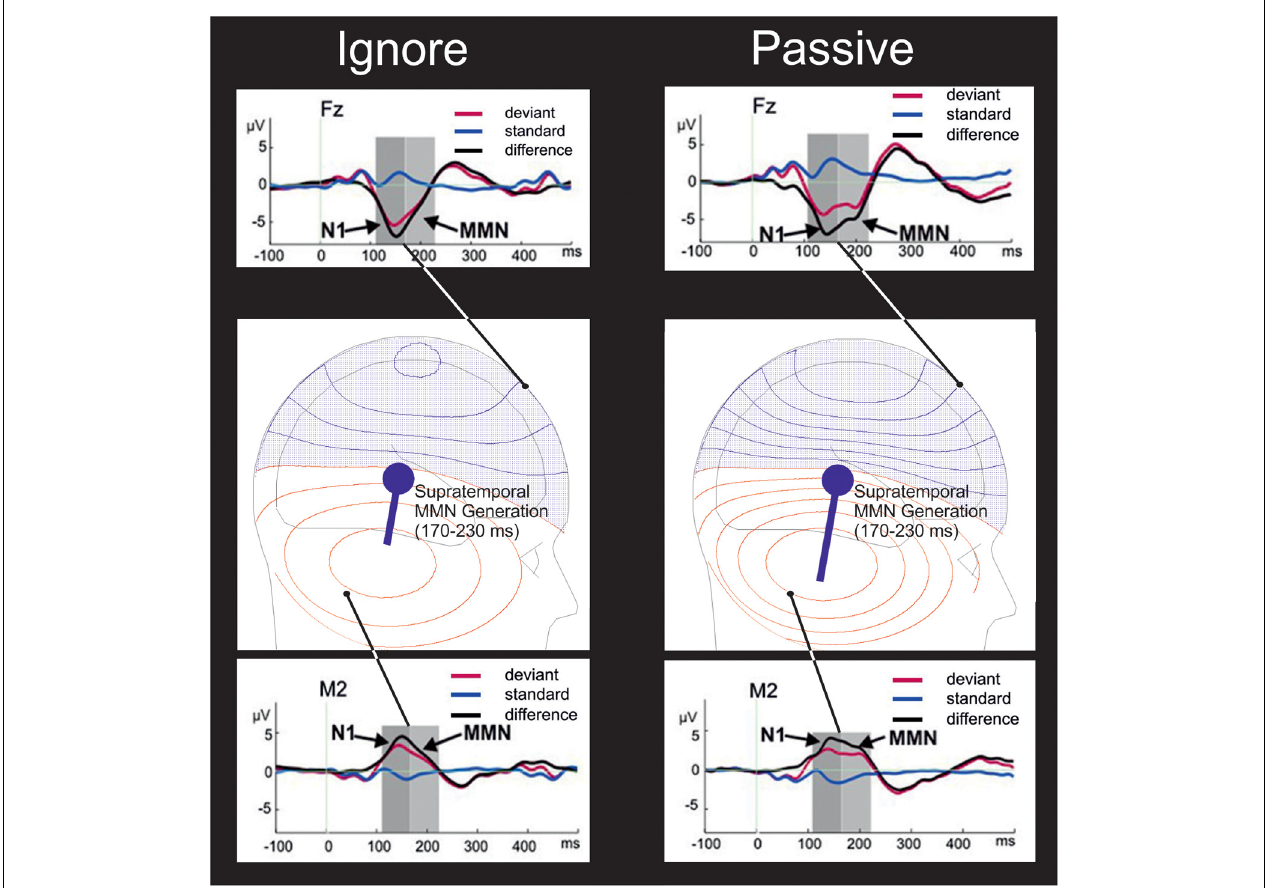
FIGURE 1 | Theoretical schematic of the influence of attention on supratemporal MMN generation. In the “ignore” condition (left panels) , participants performed a visual task in which attention is drawn away from the to-be-ignored auditory stimulation by a primary visual task of detecting a scene in a silent movie. In the “passive” task (right panels) participants watched that movie whilst just ignoring the sound. As illustrated in the middle row of panels, attention to the sounds in the passive task is assumed to increase supratemporal MMN generation by a population of tens of thousands of similarly oriented axons/dendrites of neuronal elements firing simultaneously within each hemisphere in response to auditory deviance, the cumulative action of which can be approximated by a dipolar source of a primary current (denoted by a blue circle) in each hemisphere giving rise to volume currents passing through the brain, liquor, skull, and scalp to Electroencephalogram (EEG) electrodes. The moment of that dipole – represented by the length of a straight line vector originating from the dipolar source location tangentially oriented to the skull – is reduced by the engagement of visual attention during the “ignore” task, attenuating the amplitude of the negative voltage (blue isopotential contours) of the frontally maximal MMN (upper row of panels) and also attenuating the corresponding amplitude of the polarity reversal; a positive voltage (red isopotential contours) at the mastoids (lower row of panels). Each neighboring contour describes a fixed step in scalp potential. Thus, as apparent at the electrodes shown (black dots), with a higher density of such isopotential contours simulated in the passive condition, both MMN at a frontal electrode (Fz) and the MMN polarity reversal at the right mastoid (M2) exhibited higher amplitudes in the passive than in the ignore task. As depicted by the observed deviant-standard difference waves in the upper and lower rows of panels, there is an increase of the N1 deflection (Jacobsen and Schröger,